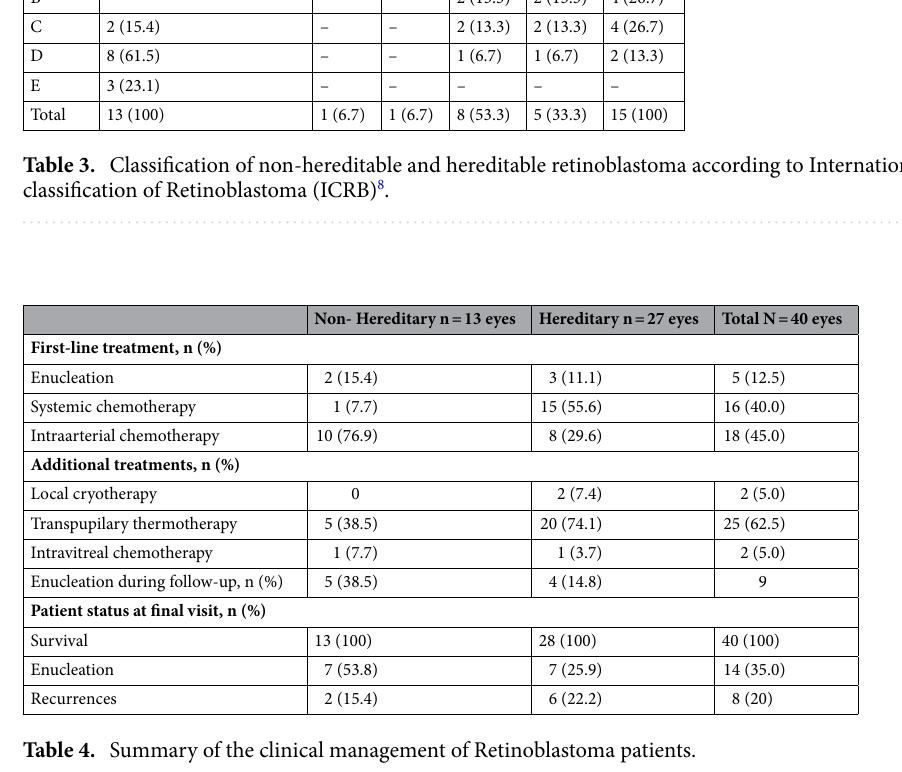
(Table 3), 13 (86.7%) presented with one of the eyes with advanced intraocular retinoblastoma (group D or E), from which 2 (13.3%) presented group D or E lesions in both eyes. In this group, 3 patients presented with unilateral retinoblastoma, staged as follows: 1 group A and 2 group D. During the study period, 14 children had one eye enucleated due to retinoblastoma. In the non-hereditable retinoblastoma group 6 (46.2%) of the affected eyes were preserved. In the hereditary retinoblastoma group, 8 (53.3%) children had both eyes preserved and 7 (46.7%) children had one eye preserved. No deaths were regis- tered during the study period (Table 4).